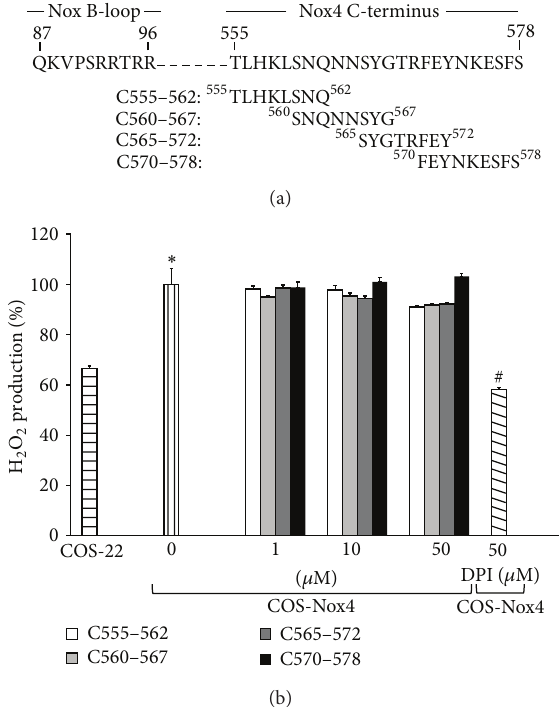
Figure 2: Examination of Nox4 C-terminal tail peptides as Nox4 inhibitors. (a) Map of overlapping Nox4 C-terminal region synthetic octa- and nonapeptides used to inhibit Nox4 activity. Numbers correspond to location and span of the N- and C-terminus for each peptide. (b) COS-Nox4 cell lysates were preincubated with various concentrations of C555–562, C560–567, C565–572, and C570–578 for 15min at 24 ∘ C, and H 2 O 2 was measured using Amplex Red. Data represent the mean ± SEM of 3 experiments. ∗ 𝑃 < 0.05 indicates a significant difference between COS-22 and COS-Nox4 cell lysates. # 𝑃 < 0.05 indicates a significant difference between COS-Nox4 + 0 𝜇 M peptide and COS-Nox4 + DPI.